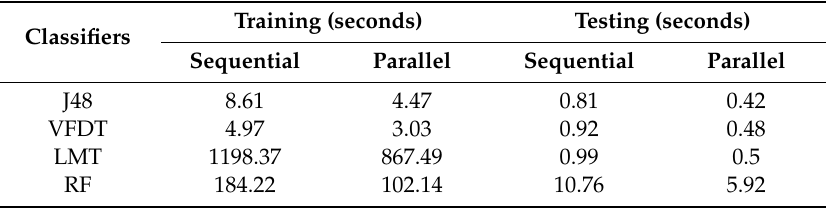
Table 6. Comparison of processing time between sequential mode and parallel mode when using CST-GR features.